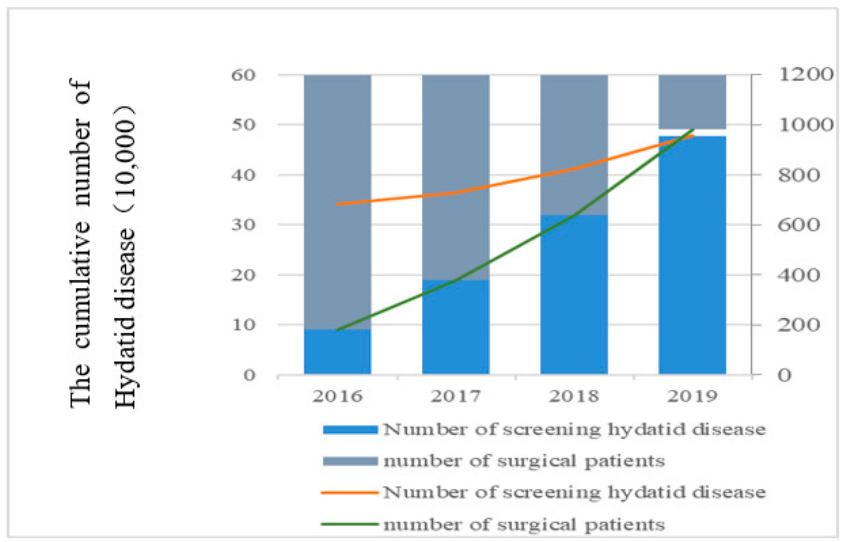
Figure 5. The cumulative number of surgical patients and Hydatid disease screened in Yushu Prefecture from 2016 to 2019. Prefecture from 2016 to